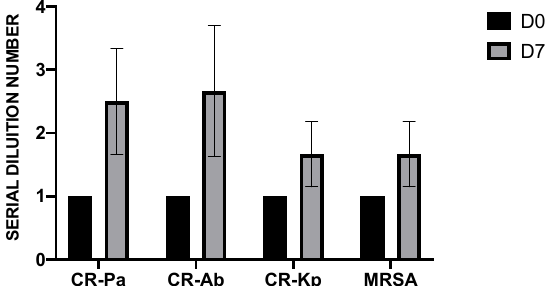
Figure 1. Antibacterial activity of fecal water samples collected from six healthy donors before (day 0, D0) and after (day 7, D7) 7 days of probiotic supplementation against clinical strains of carbapenem-resistant (CR) P. aeruginosa (Pa), CR A. baumannii (Ab), CR K. pneumoniae (Kp), and methicillin-resistant S. aureus (MRSA). The serial dilution number (y axis) corresponds to the number of the serial 2-fold fecal water dilutions needed to obtain the corresponding minimal bactericidal dilution (MBD). Values are represented as mean ± standard deviation (SD).